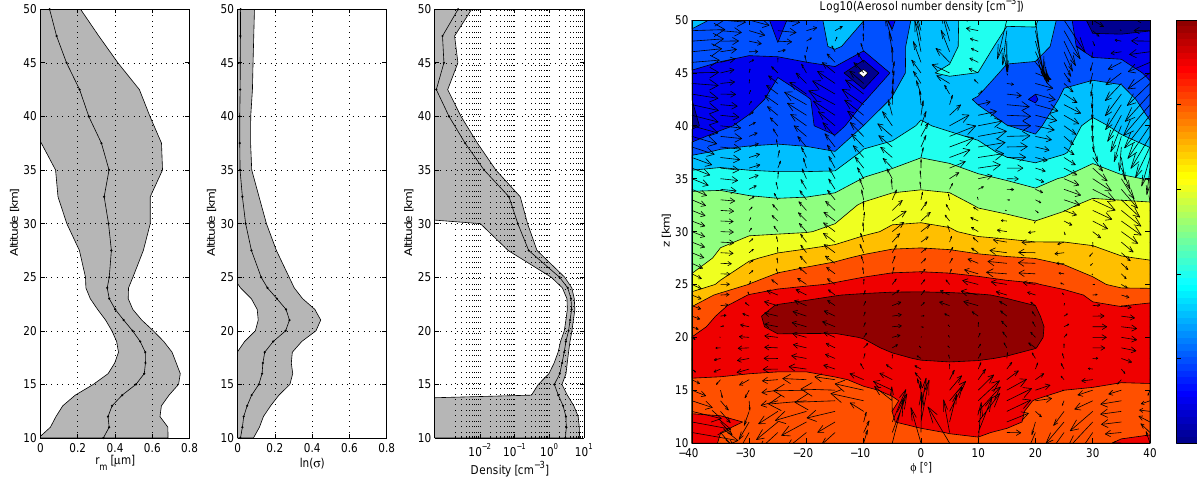
Fig. 1. Mean vertical profiles for r m , ln ( σ ) and N . Fig. 2. Contour plot of the decimal logarithm of the time-averaged aerosol total number density. UKMO velocity fields have been su-